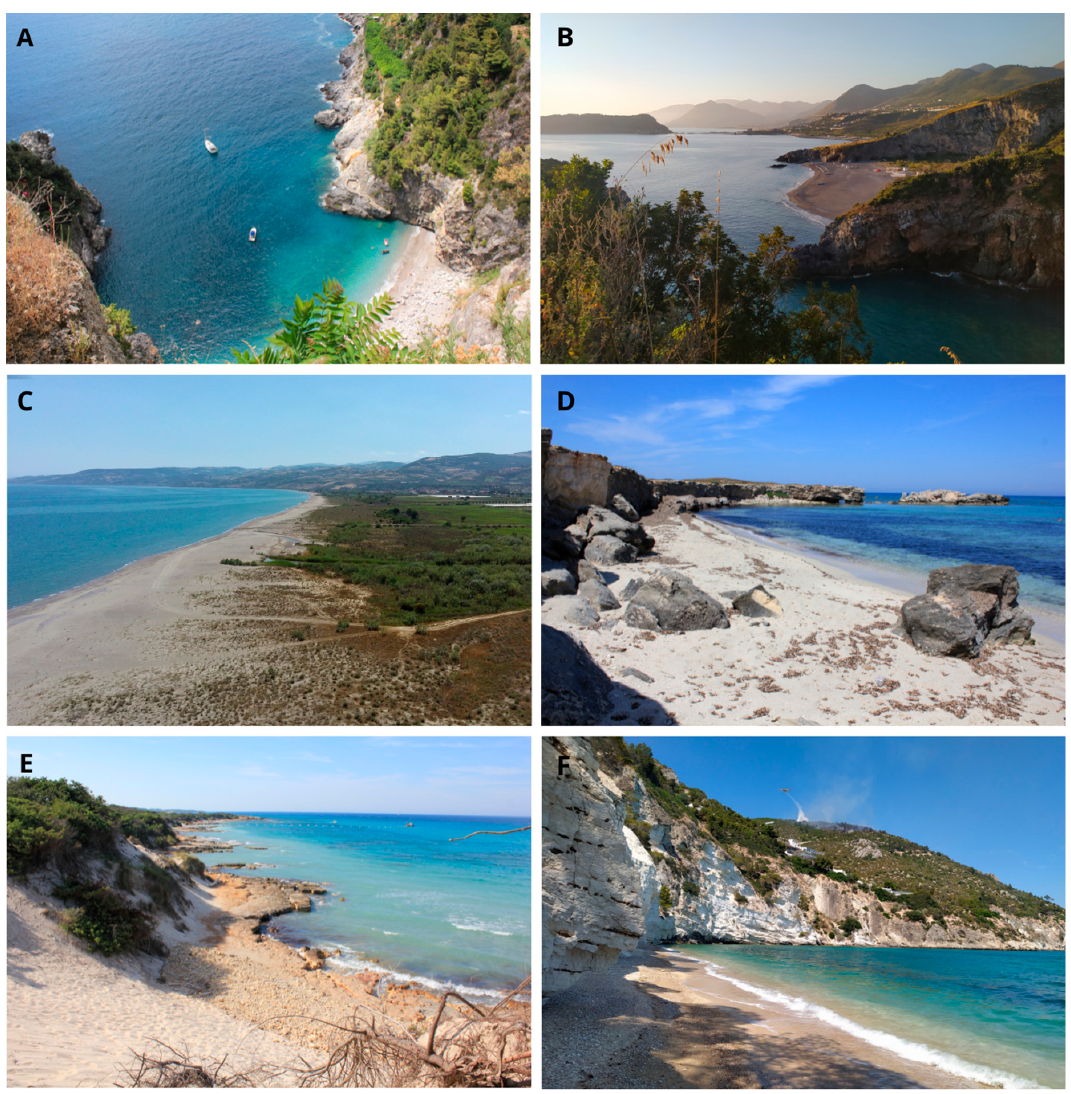
Figure 3. Pocket beach of Cavallo Morto (D: 0.93, Class I) at Sorrento peninsula, Amalfi coast, with a cliff height >100 m ( A ); coastal relief and landscape features along the northern coast of Cosenza with Scorzone in the background (D: 1.00, Class I; ( B )); eastern coast of Cosenza stretching the Ionian Sea (D: 0.83, Class II; ( C )); crystal-turquoise waters and islet at Torre Specchia (D: 0.87, Class I; ( D